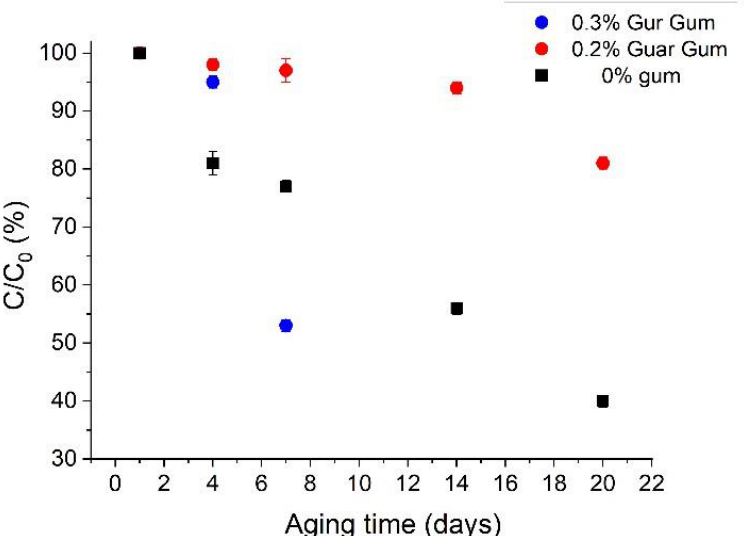
Figure 5. Influence of aging time on the chemical degradation of β -carotene encapsulated within the emulsions as a function of guar gum concentration and the reference sample (pure linseed oil) measured using a solvent extraction and spectroscopy